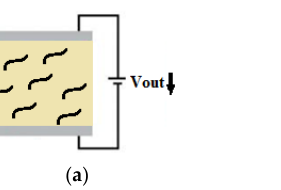
Figure 1. Illustration of the changes at a sensing point: ( a ) When the sensor is not pressed; ( b ) When the sensor is pressed. (Reprinted with permission from Ref. [12] Copyright 2020 IEEE).